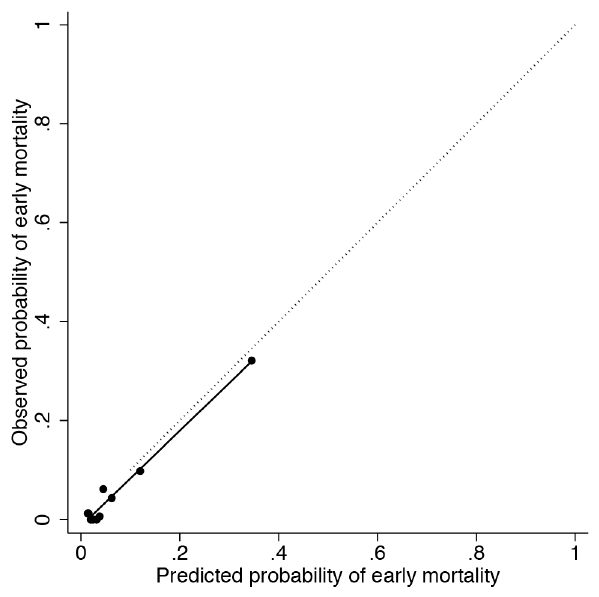
Figure 2. Calibration plot after shrinkage for the risk of early mortality among adult trauma patients model. The dotted line represents perfect calibration. The solid line is the calibration line, calibration slope is 0.96.